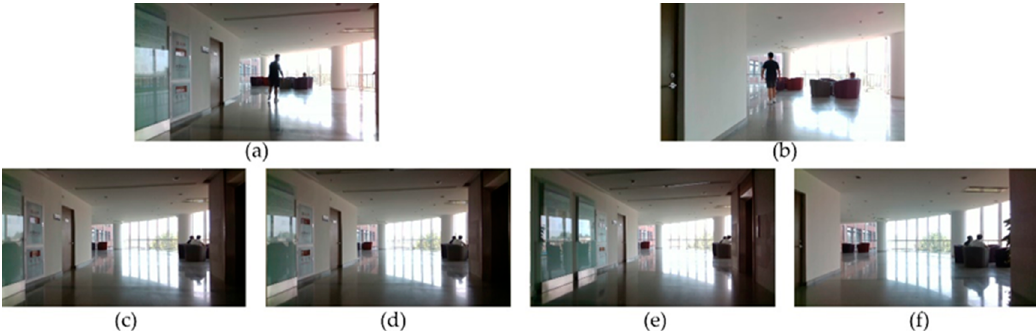
Figure 7. Query images in corridor scene and query results: ( a ) Query image no. 1; ( b ) query image no. 2; ( c ) query result of image 1 with the VLAD method; ( d ) query result of image 1 with our proposed method; ( e ) query result of image 2 with the VLAD method; ( f ) query result of image 2 with our proposed method. Table 1. Pose estimation result of VLAD and our proposed method (position, unit: m). Scene Query Image No.